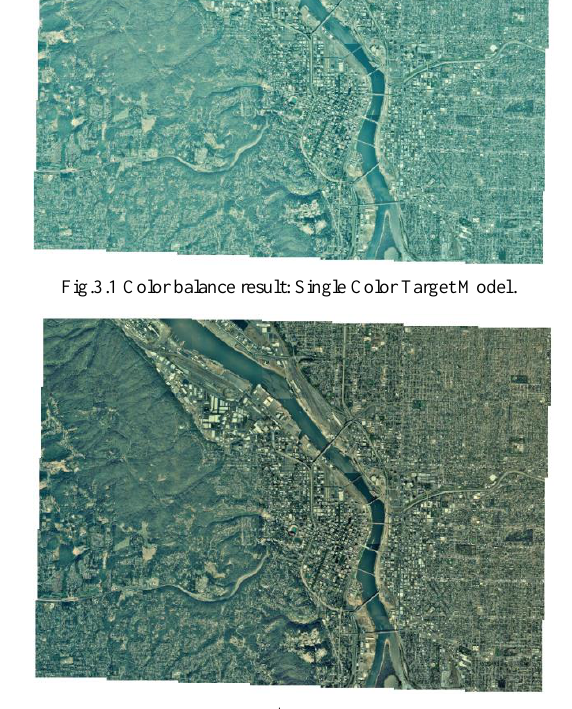
Fig.3.2 Color balance result: 1 st Order Polynomial Target Model.